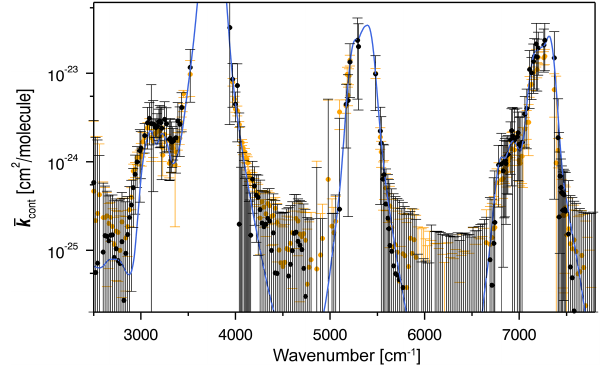
Figure C1. Mean continuum absorption coefficient ¯ k cont deter- mined from 12 December 2013 spectra using the Langley method and corresponding 2 σ uncertainties (black). Results are compared to the calibrated method for the same spectral data set (orange) and the MT_CKD 2.5.2 model (blue).